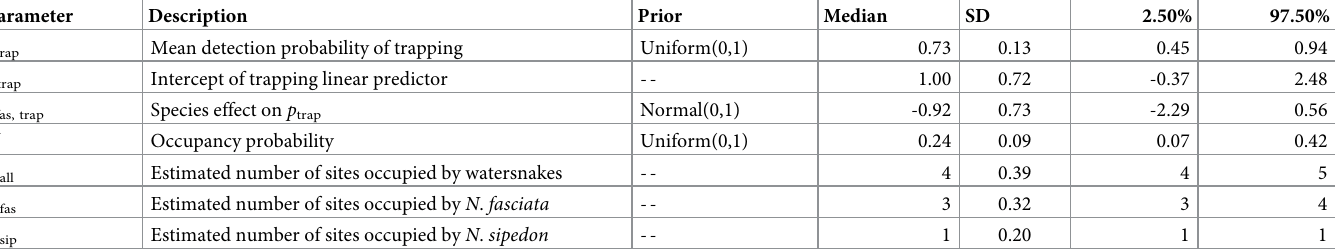
Table 6. Parameters, prior distributions, and posterior summaries for detection and occupancy parameters from an occupancy model based on trapping surveys